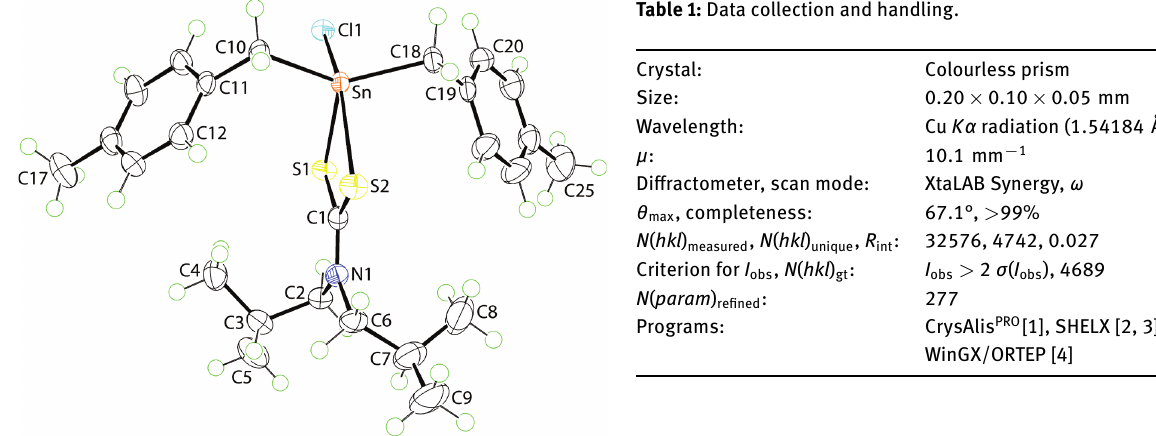
Table 2: Fractional atomic coordinates and isotropic or equivalent isotropic displacement parameters (Å 2